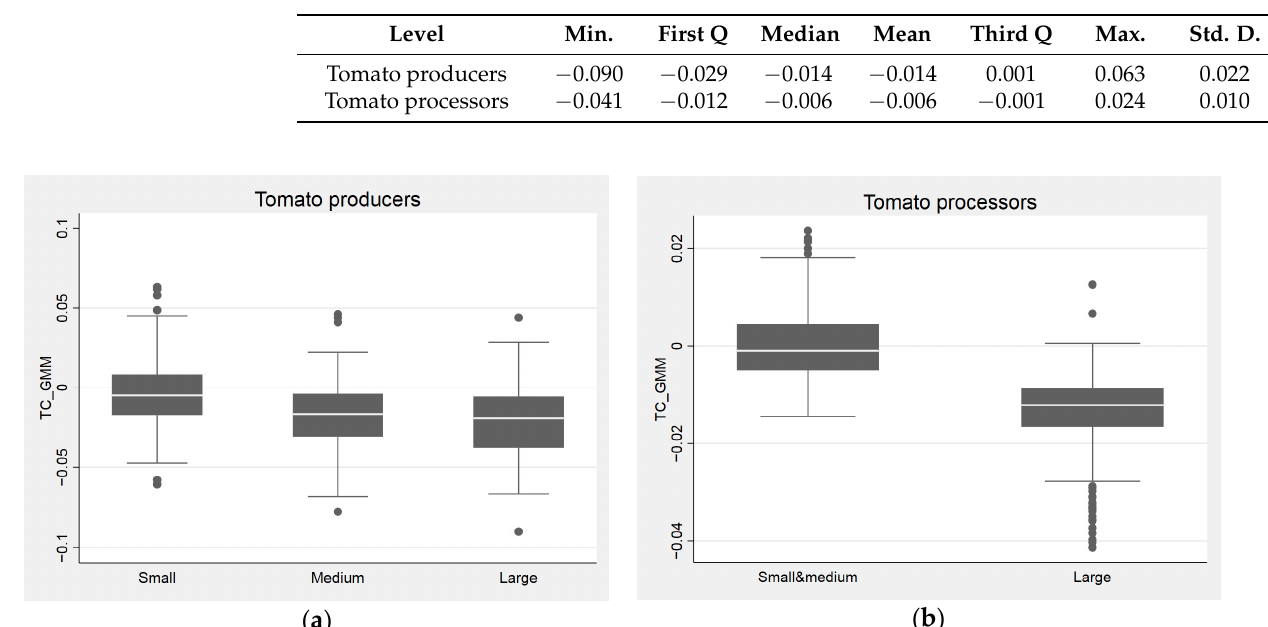
Figure 2. Distribution of technological change; ( a ) tomato producers and ( b ) tomato processors. Source: authors’ calculations.